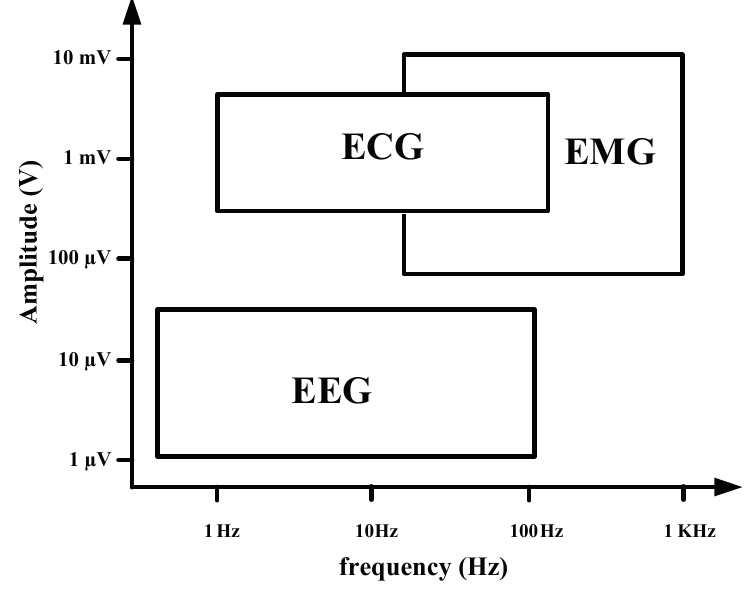
Figure 1. Amplitude and frequency band of